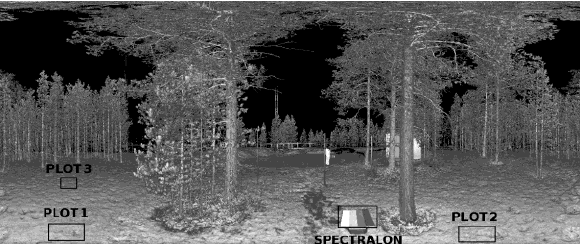
Fig. 1. Intensity image of a measurement from Tähtelä. The square plots 1, 2 and 3 are the sample plots and the Spectralon is the reference